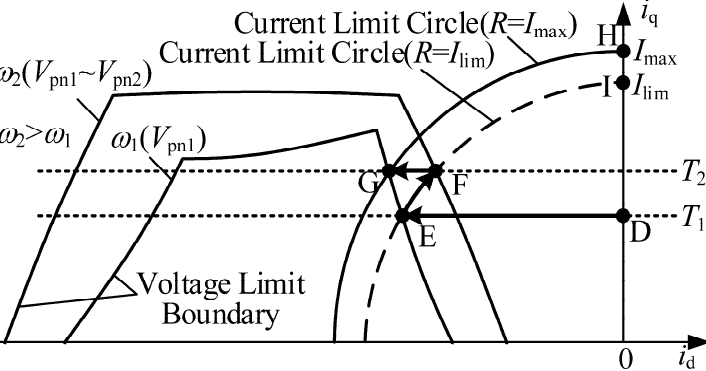
Taking the speed-up and loading process of the IMC-SPMSM in the flux-weakening region as an example, Figure 6 shows how the operation point of the system changes. In the figure, ω 1 and ω 2 represent rotor angular velocity and ω 2 > ω 1 ; T 1 and T 2 represent load torque and T 2 > T 1 .